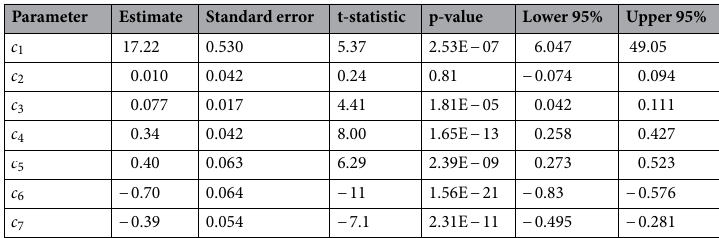
Table 3. Parameter table for simplified